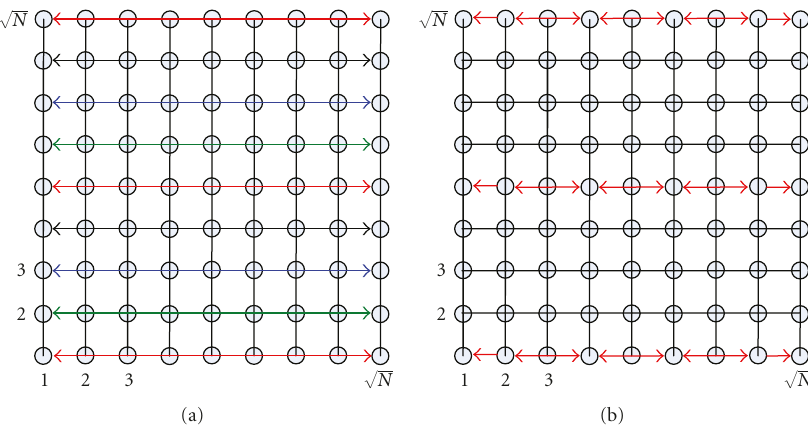
Figure 7: Subfigure (a) shows 2D grid network with one bidirectional flow in each line. The lines separated by J − 1 = 3 lines, that is, the lines with the same color, are allowed to transmit simultaneously. Subfigure (b) shows a scheduling for one group active lines (red lines) in a specific time